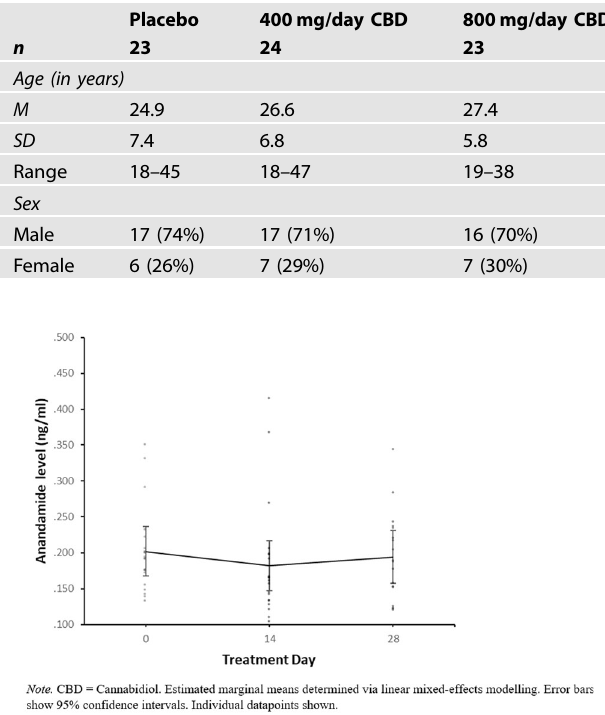
Fig. 2 Estimated marginal means of anandamide levels in the 400 mg CBD group by